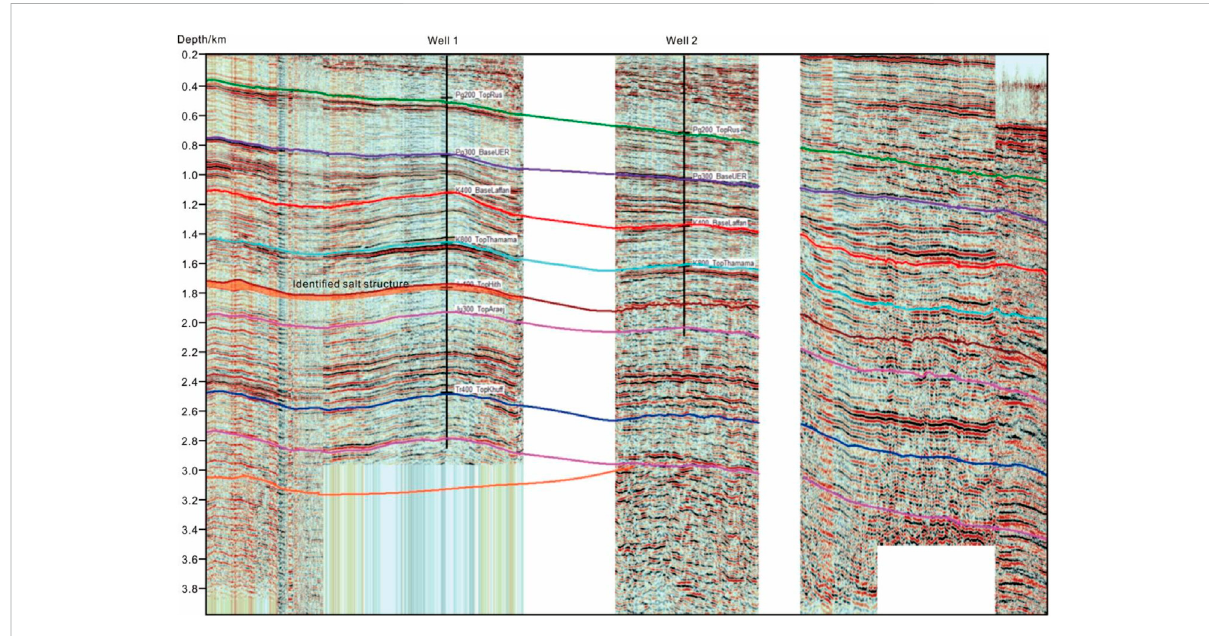
FIGURE 15 The salt identi fi cation in the sections of well 1 and well 2 (reconstructed by the ultrascale salt reconstruction algorithm; the location of this section is shown in Figure 13B).